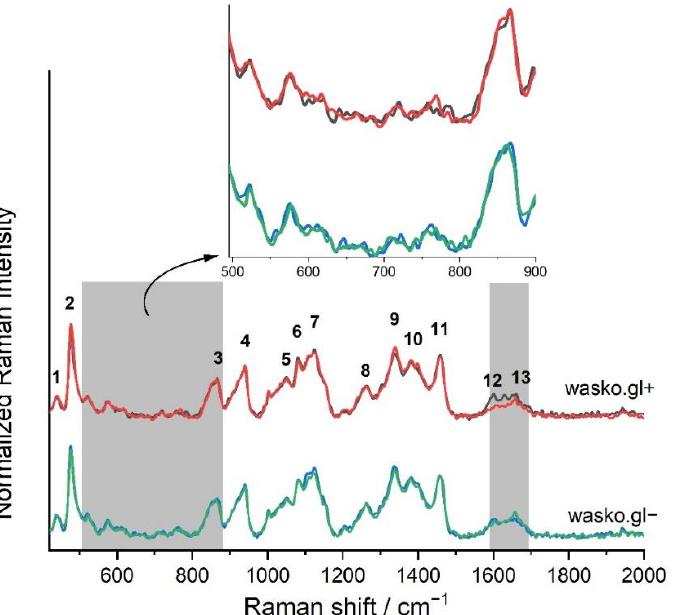
Figure 4. The normalized FT-Raman spectra of flour of two wheat lines lacking (N0) or N-fertilizers treated (N120): wasko.gl+ (red (N120) and black (N0) solid lines) and wasko.gl − (blue (N0) and green(N120) solid lines). Numbers 1–13 indicate bands typical for the main chemical components in kernels and they are characterized in Table S1 in Supplementary Materials. Inset: the spectroscopic region, 500–900 cm − 1 , typical for amino acids and SS vibrations; N ≥ 3, SD < 5%.